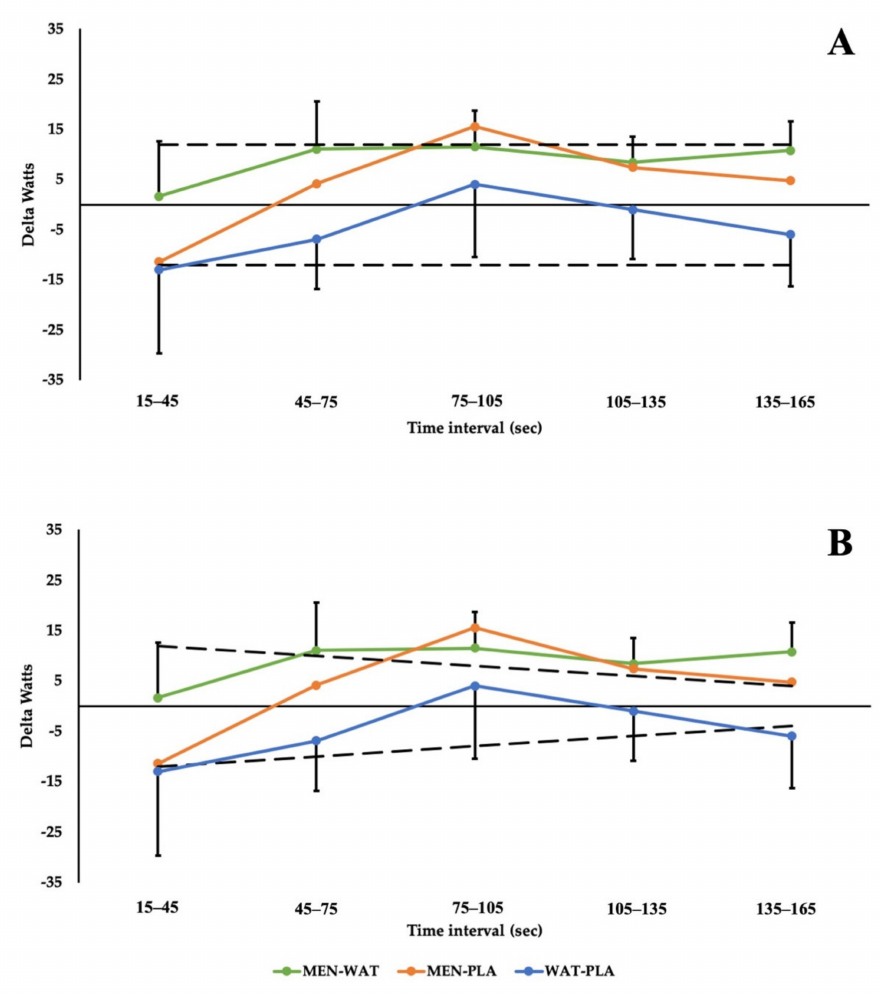
Figure 3. Differences in power output between conditions (delta W) and meaningful change. funnel, as time intervals progress, from 12 W to 5